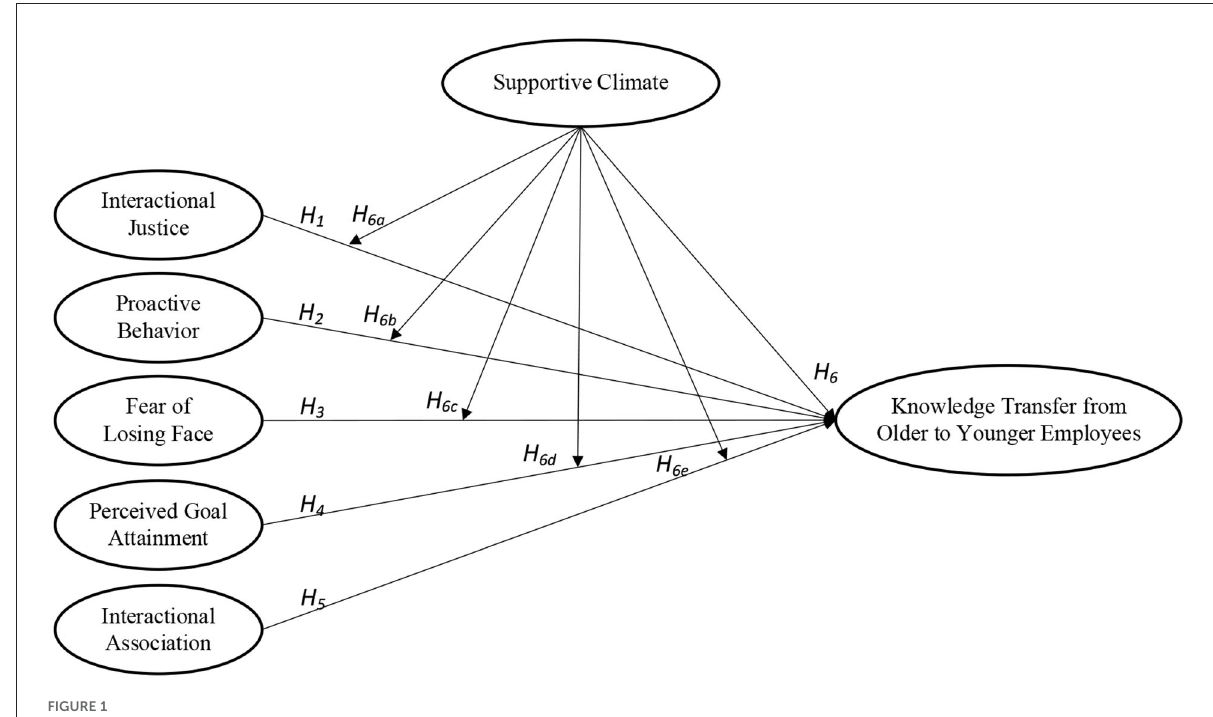
FIGURE1 Conceptual